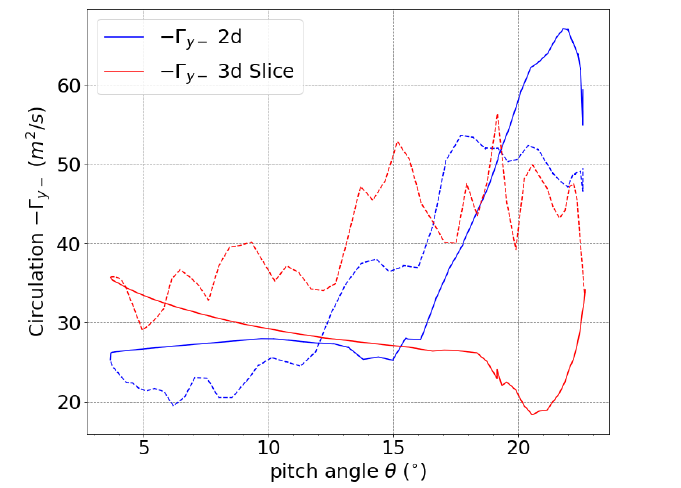
Figure 20. Vorticity strength of the counter-clockwise vortex over the upper surface of the pitching airfoil and the slice of the rotating blade, with solid lines representing the upward pitching and dashed lines the downward pitching. The circulation Γ y − =